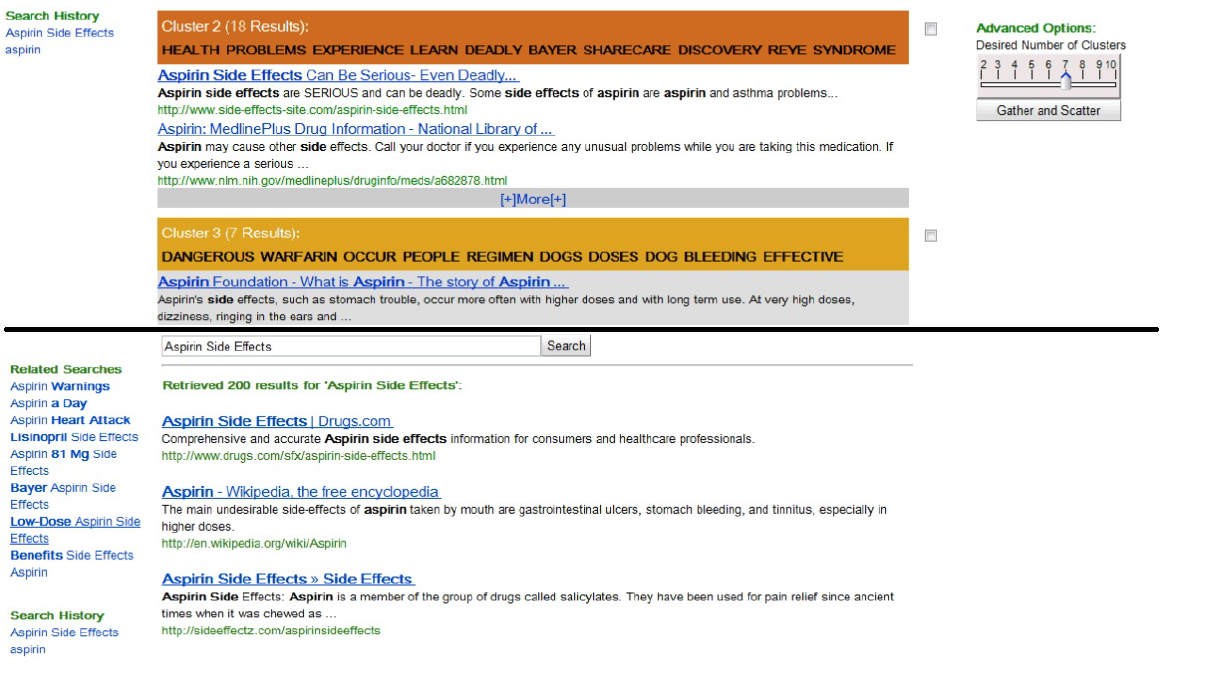
Figure 1. Screenshot of search results - the upper half of the image shows the scatter/gather interface and the lower half shows the classic